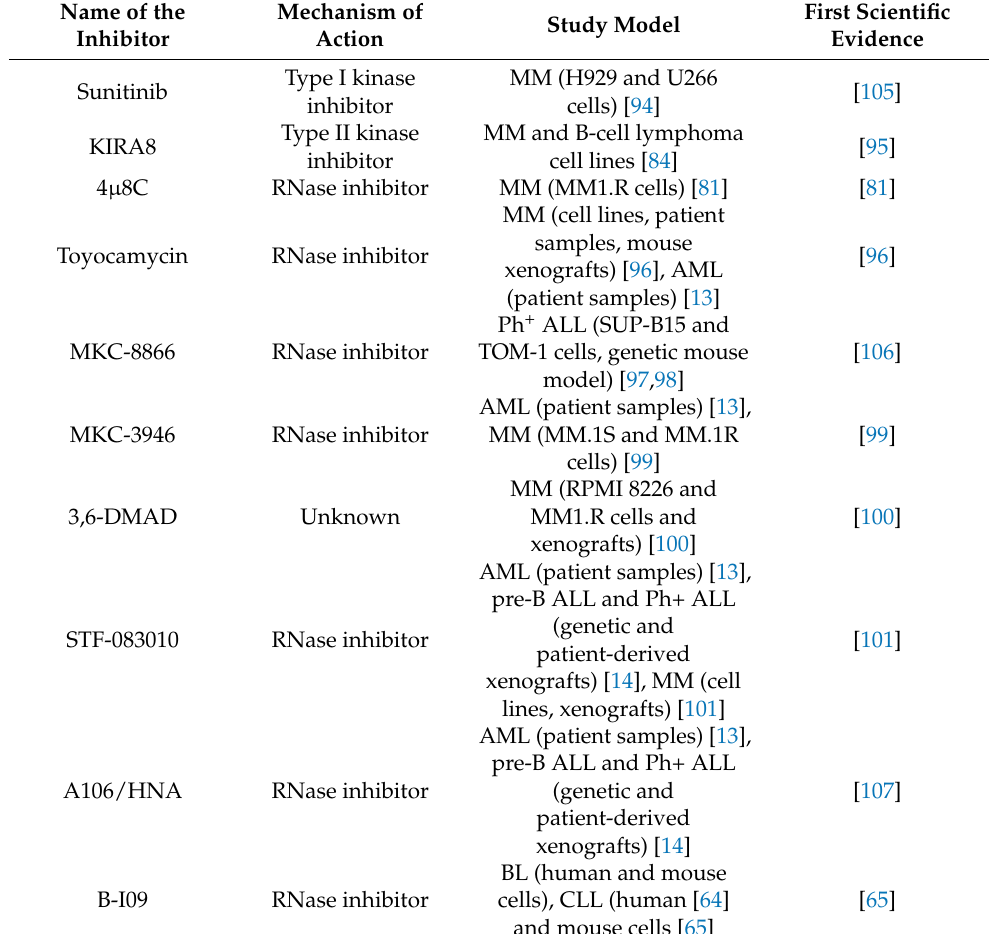
Table 2. Comparison of different inhibitors of IRE1 α protein domains by their mechanism of action and effectiveness in hematological diseases. First Scientific Name of the Mechanism of Study Model Inhibitor Action